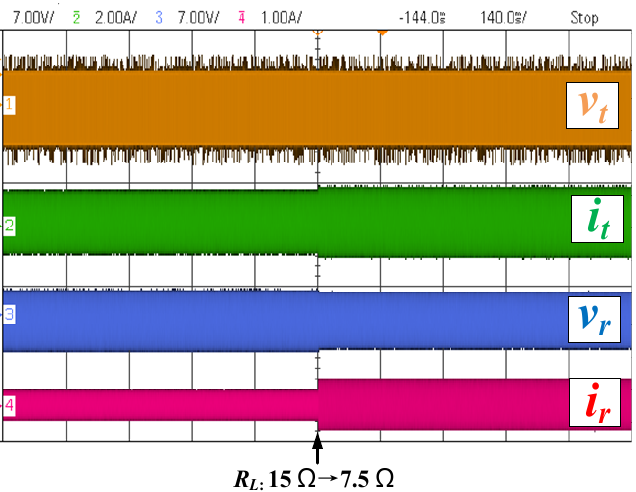
Figure 10. Transient waveforms of v t , i t , v r , and i r at f 1 for the load resistance switching from 15 Ω to 7.5 Ω.